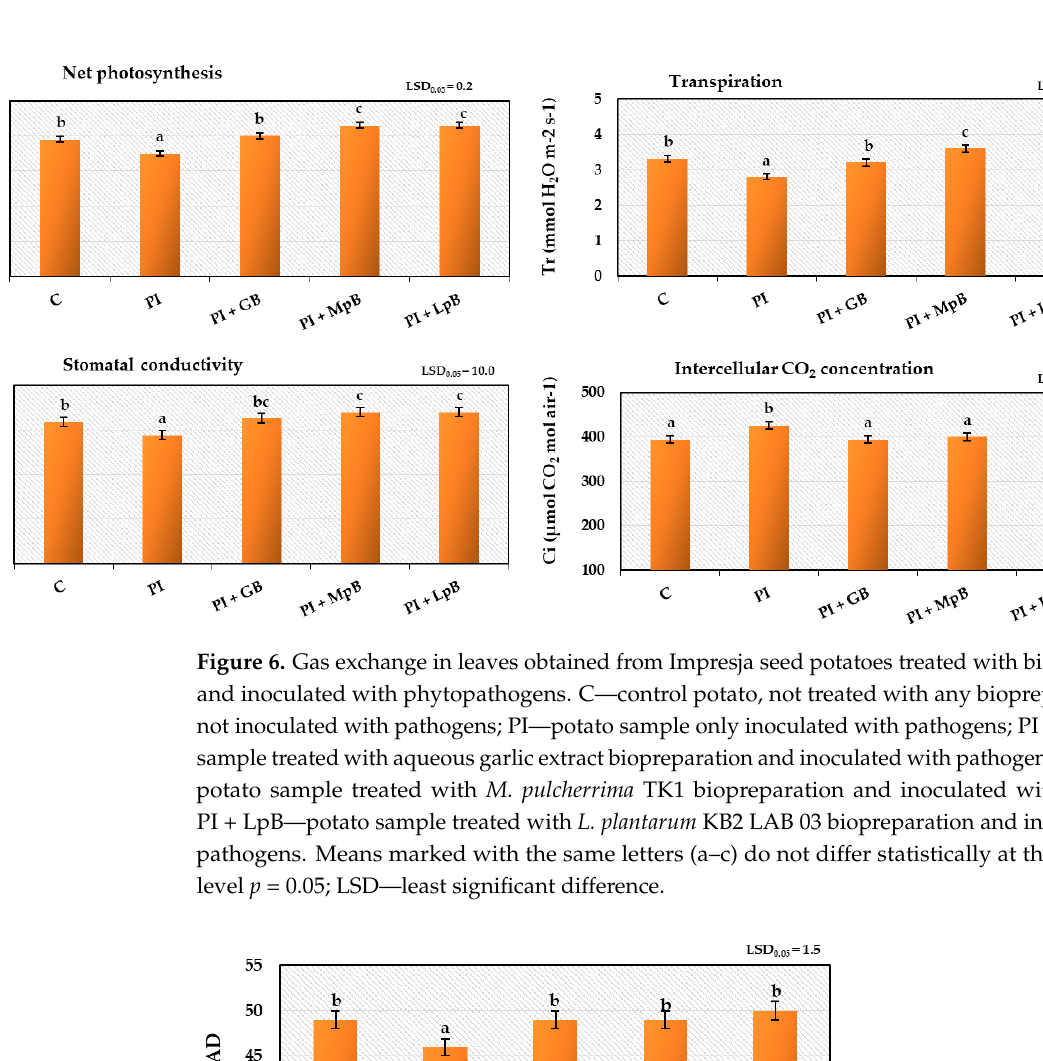
16 of 21 Figure 5. Plants obtained from seed potatoes: ( A ) infected with phytopathogens; ( B ) biologically treated and then infected with phytopathogens. 3.2.2. Gas Exchange in Leaves and Index of Chlorophyll Content in Leaves The study of gas exchange activity in leaves (net photosynthesis, transpiration, stomatal conductivity, and intercellular CO 2 content) and the index of chlorophyll con- tentconfirmed the correlation between the methods of biological treatment of seed pota- toes and the development of roots and stems, as discussed in Section 3.2.1. (Figures 6 and 7). Inoculation of seed potatoes with phytopathogens adversely affected gas exchange and the index of chlorophyll content in leaves. Treatment of seed potatoes with bio- preparations, especially MpB and LpB, significantly increased this activity. The obtained